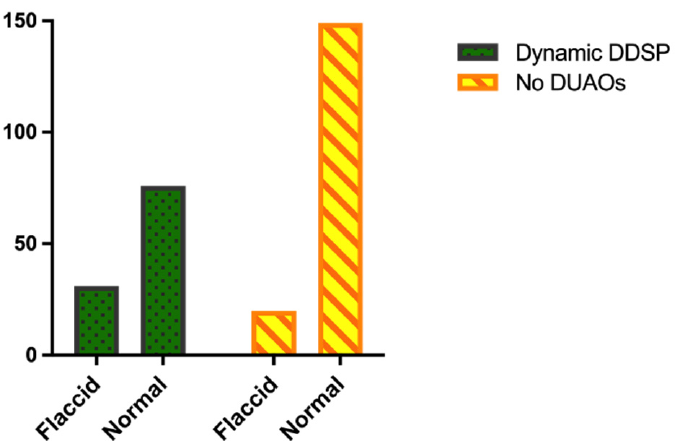
Figure 2. Stacked bars showing the frequency of alterations at upper airway resting endoscopy in the different groups (no-DUAO, mild-DUAO, severe-DUAO and multiple-DUAOs).